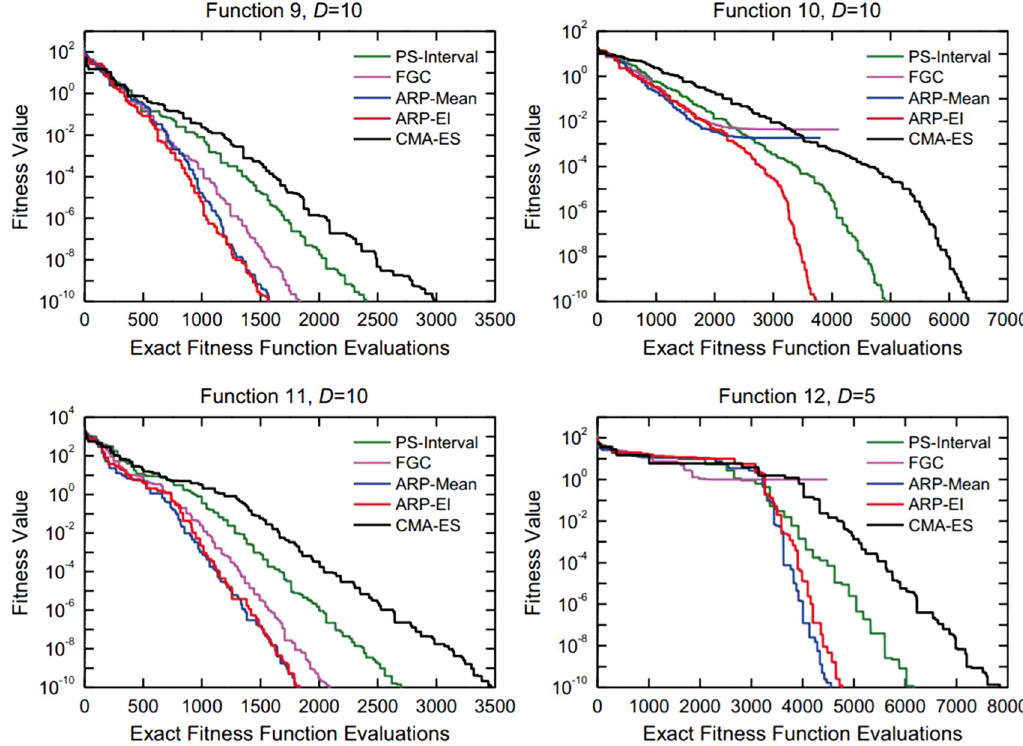
Fig. 3. Convergence graphs of f 9 – f 11 .